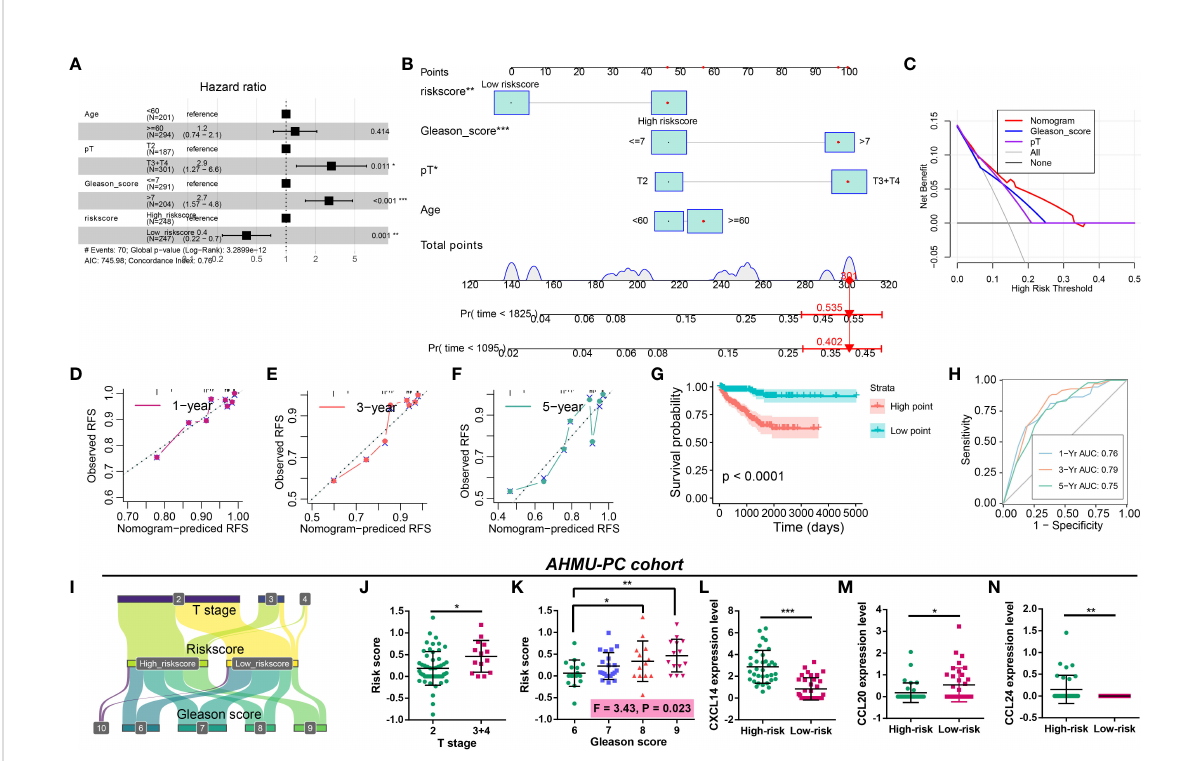
FIGURE 9 Construction of the CRPGS-based nomogram and validation of the CRPGS in the AHMU-PC cohort. Results of multivariate Cox regression with age, pathology T stage, Gleason score, and riskscore in PCa (A) . The CRPGS-based nomogram that integrated age, pathology T stage, Gleason score, and riskscore (B) , and the decision curve analysis and the 1/3/5-year calibration curves were used to evaluate the established nomogram (C – F) . Survival analysis between high- and low-nomogram-derived point (G) , and the point-based 1/3/5-year time-dependent ROC analysis were performed to assess the nomogram-derived point (H) . The Sanky plot showed the association between riskscore, T stage, and Gleason score (I) , and the distribution between patients with different T stages and Gleason scores (J, K) . The distribution in the expression levels of CXCL14, CCL20, and CCL24 in high- and low-risk patients (L – N) . *p < 0.05; **p < 0.01; ***p <